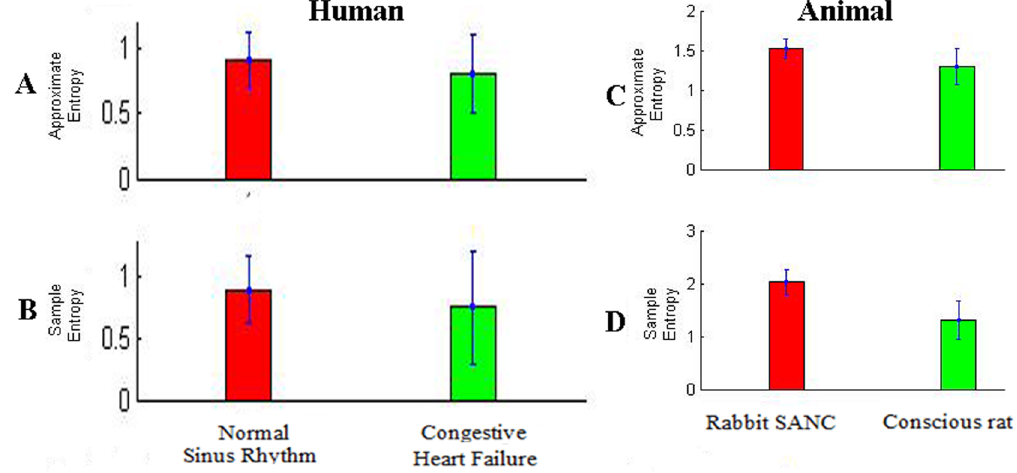
Fig 3. Differences in heart rate variability (HRV) among different cardiac preparations (baseline conditions) using Approximate Entropy and Sample Entropy, a nonlinear time series